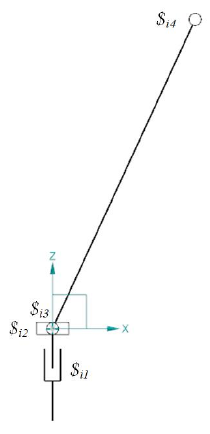
Figure 2. Four PUR-branched